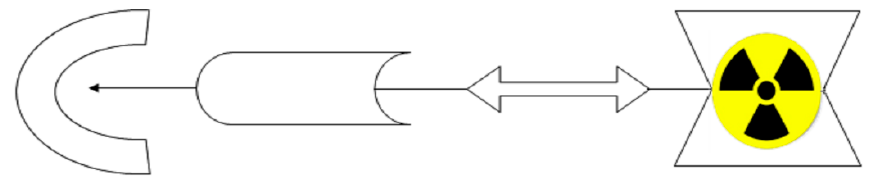
Figure 1. Basic scheme of a potential target-specific